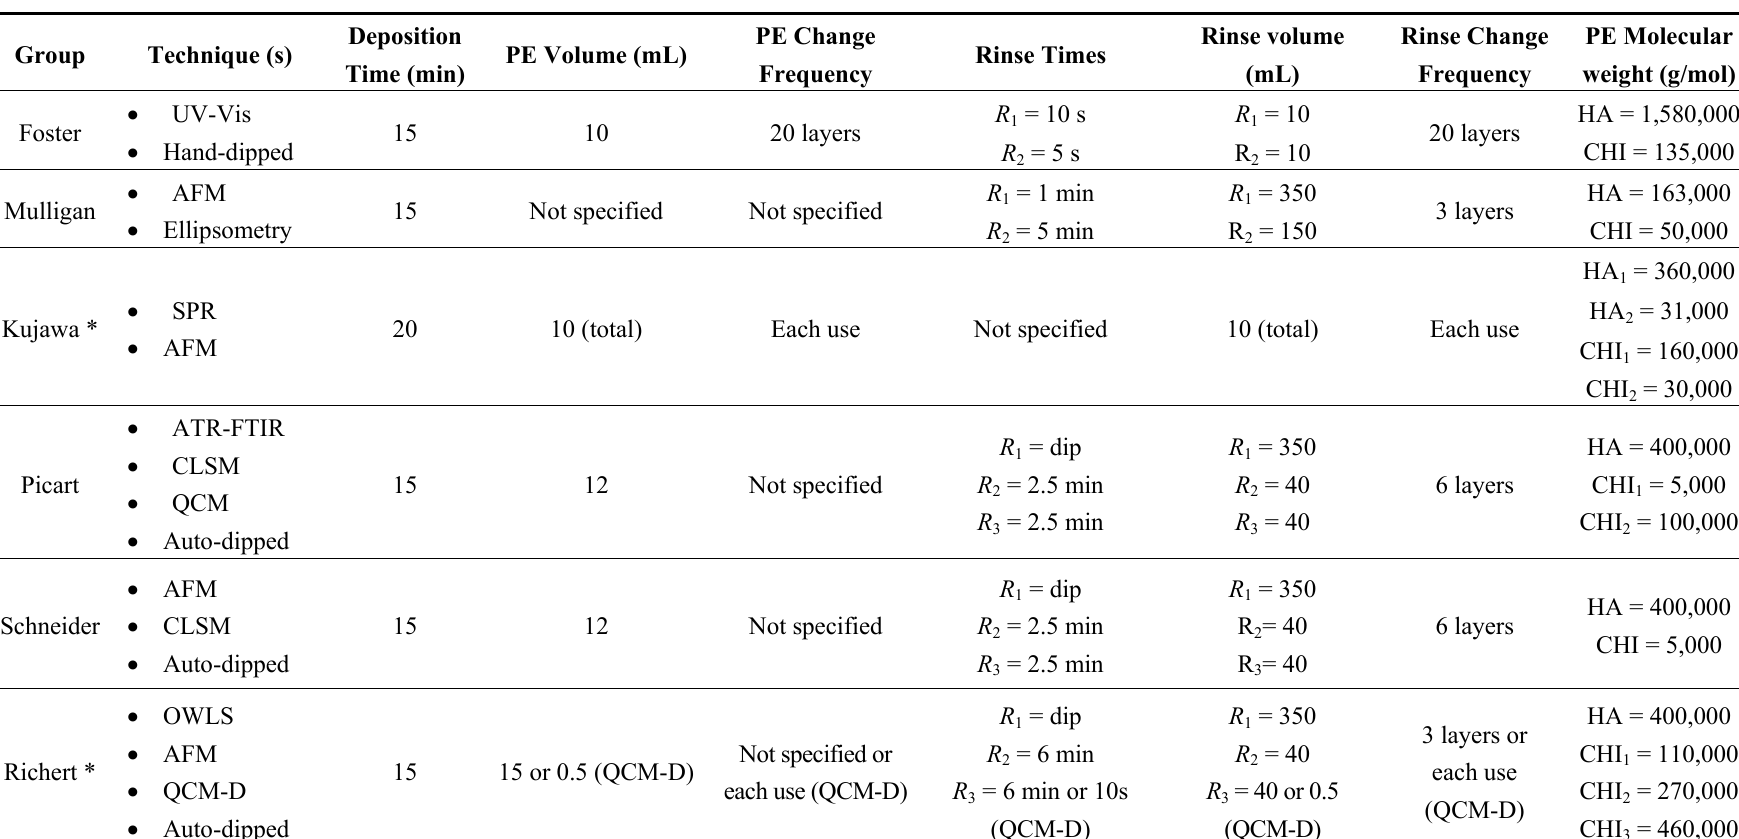
Table 1. Review of deposition conditions from literature comparing key parameters of chitosan (CHI)/hyaluronan (HA) film experiments [18,27–29,43]. Asterisks (*) show conditions with confirmed exponential growth.